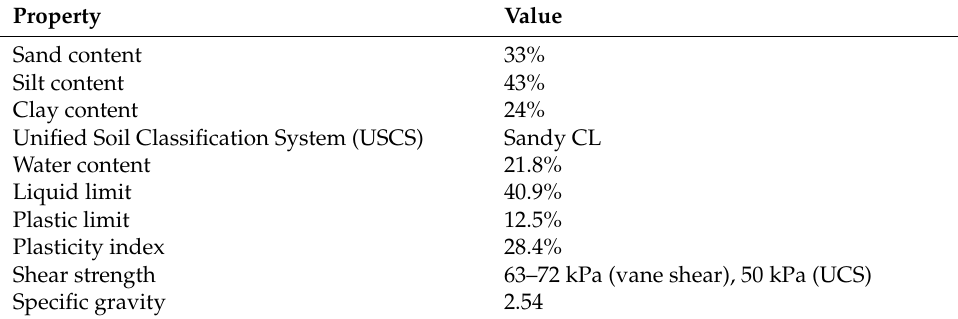
Table 4. Natural soil characteristics.